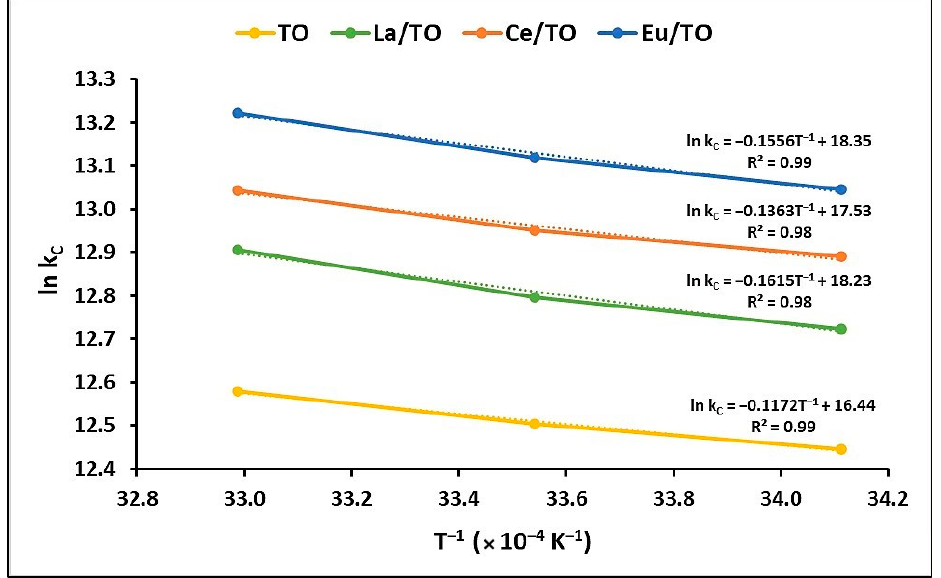
Figure 8. Thermodynamic study of cyanide adsorption onto nanoparticles.